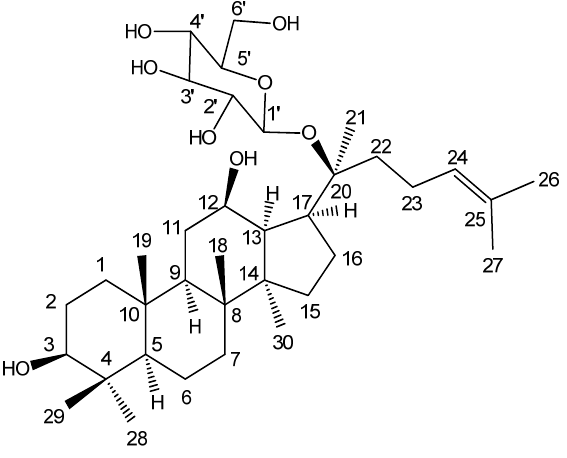
Figure 1. The structure and atom numbering of